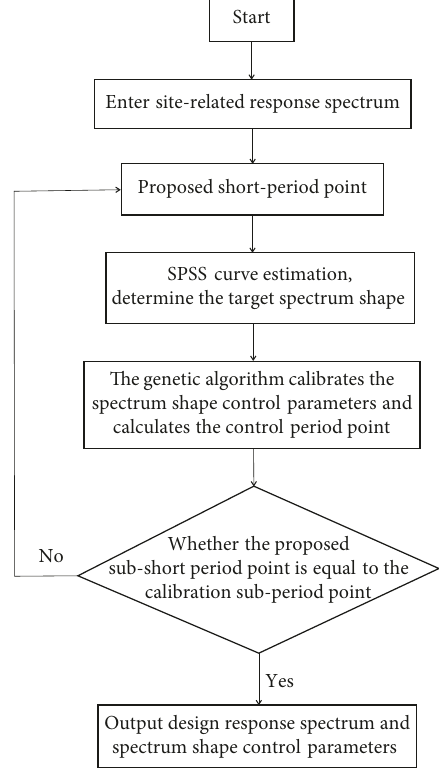
Figure 3: The calibration flow chart of the site-related design response